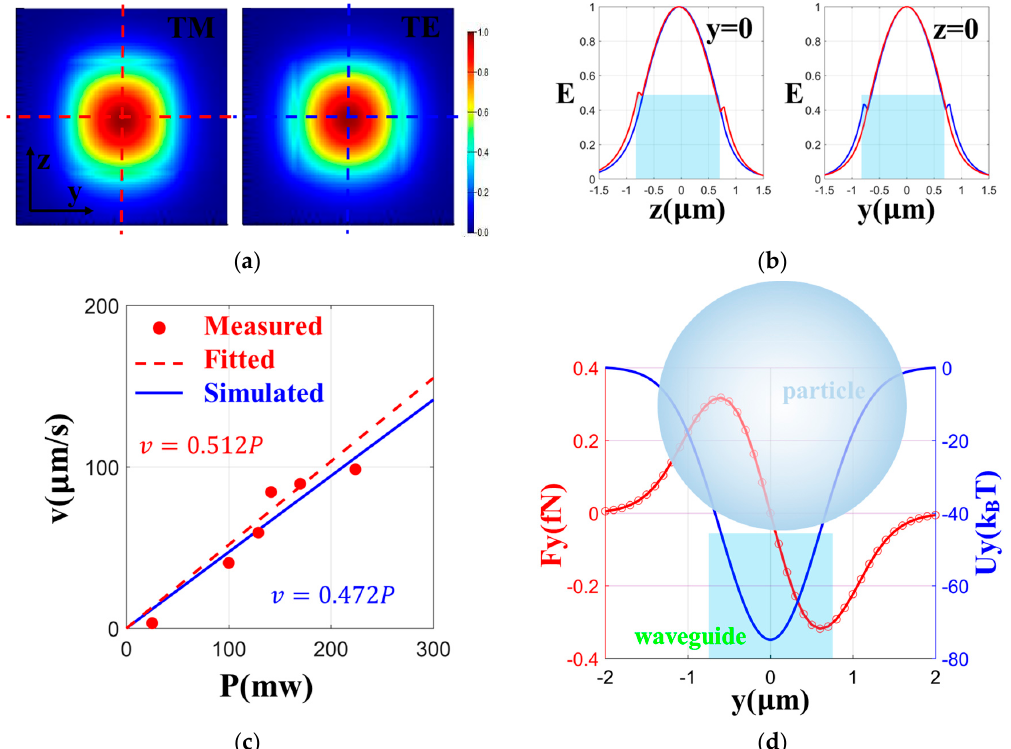
Figure 2. ( a ) The TM and TE mode distribution in the waveguide cross section. ( b ) The electric field E of four dotted lines passing through the centre of the section with a change with the z-direction (left) or y-direction (right). The line in TM is blue, and the line in TE is red. ( c ) The fitting red dotted line between the particle velocity v and power P obtained by the data in the experiment (red dots). The corresponding simulation results are represented with a blue line. ( d ) The gradient force and the corresponding optical potential well along the y-direction.